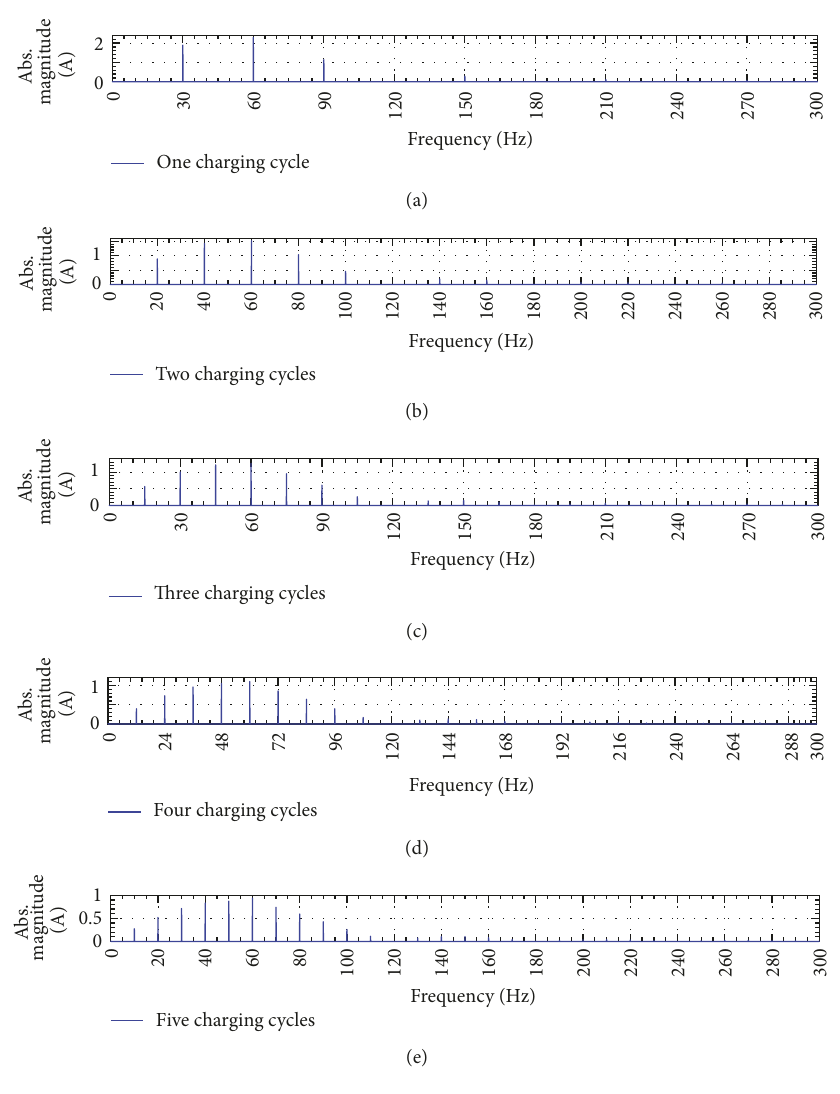
Figure 6: FFT magnitude for output current waveforms of microinverter during burst mode ((a–e) 26%, 17%, 14%, 12%, and 10%).